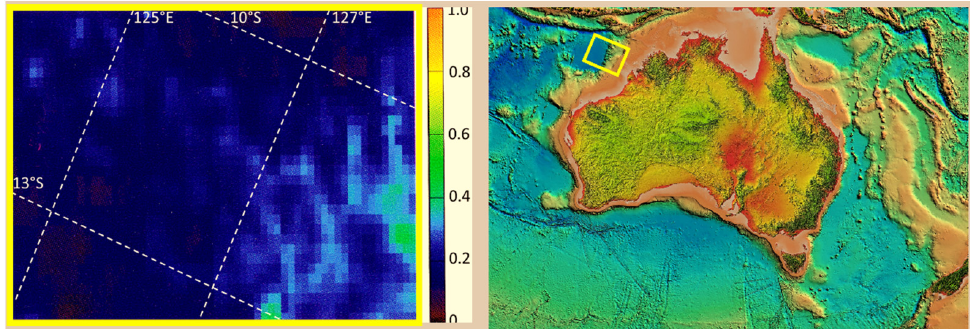
Figure 42. Internal wave signatures of internal waves crossing the continental shelf. In this case, only the modulation of wave height is shown, but other more sophisticated signatures can be retrieved.